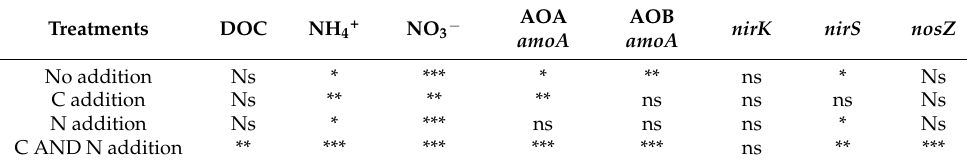
Table 3. Effect of ZnO NPs on soil DOC, NH 4+ , and NO 3 − contents and functional genes (AOA